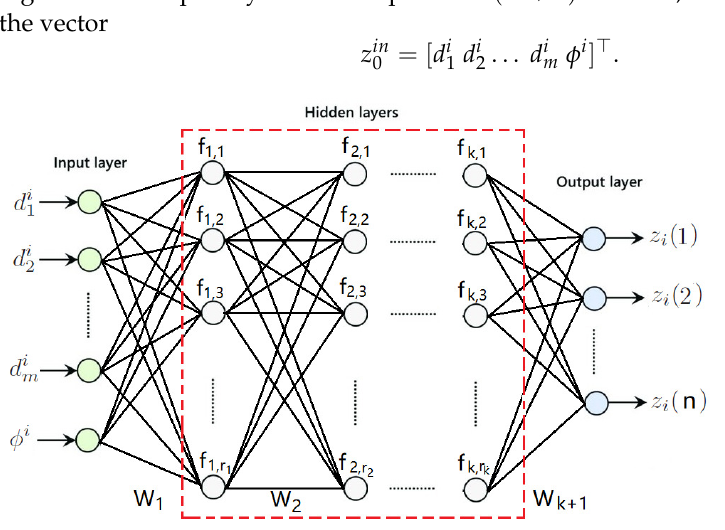
Figure 3. The structure of the neural network